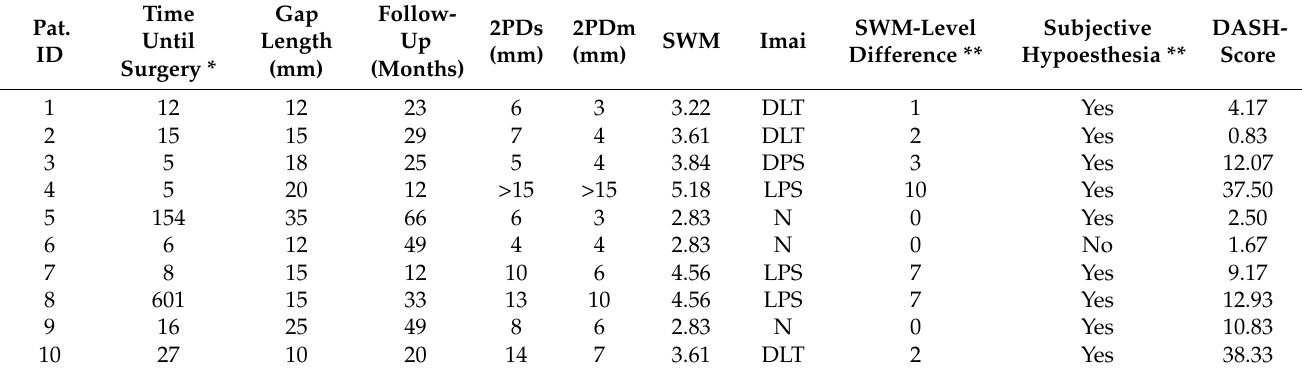
Table 2 provides detailed information on follow-up evaluation. Table 2. Postoperative